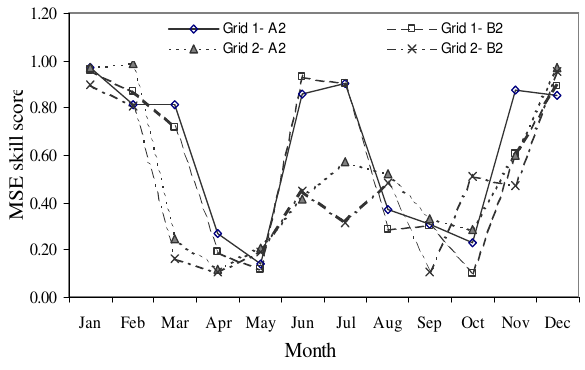
Fig. 7. Monthly variation in MSE skill scores for ECHAM4/OPYC rainfall with bias-correction